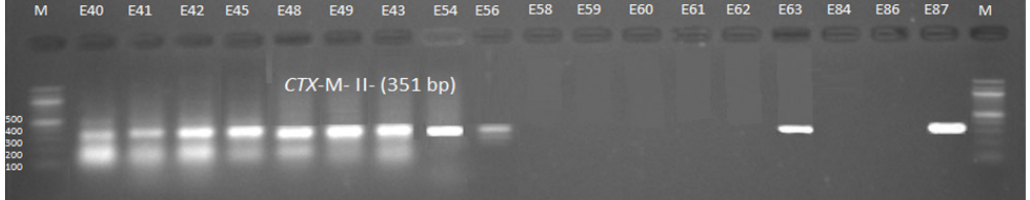
Fig. 4. 1.5% Agarose gel electrophoresis at 72 volt for 90 minutes of PCR to blaCTX-M-II amplicon (351bp); lane M represent DNA marker size(100bp) while E40-E87 represent the isolates